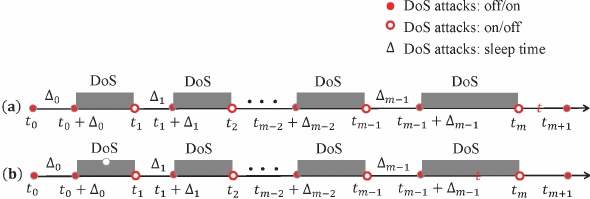
Figure 2. Situation of aperiodic DoS attacks. ( a ) presents the current instant in the sleeping interval, and ( b ) presents the current instant in the DoS attack